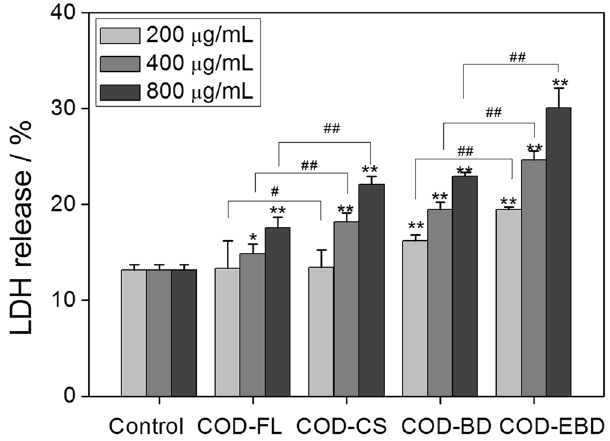
Figure 4. Changes in LDH release amount of HK-2 cells caused by different concentrations of COD crystals with various shapes for 6 h. Compared with control group, * p < 0.05. ** p < 0.01. COD-FL treatment group vs corresponding concentration of COD-CS treatment group, COD-BD treatment group vs corresponding concentration of COD-EBD treatment group, # P < 0.05, ## P <